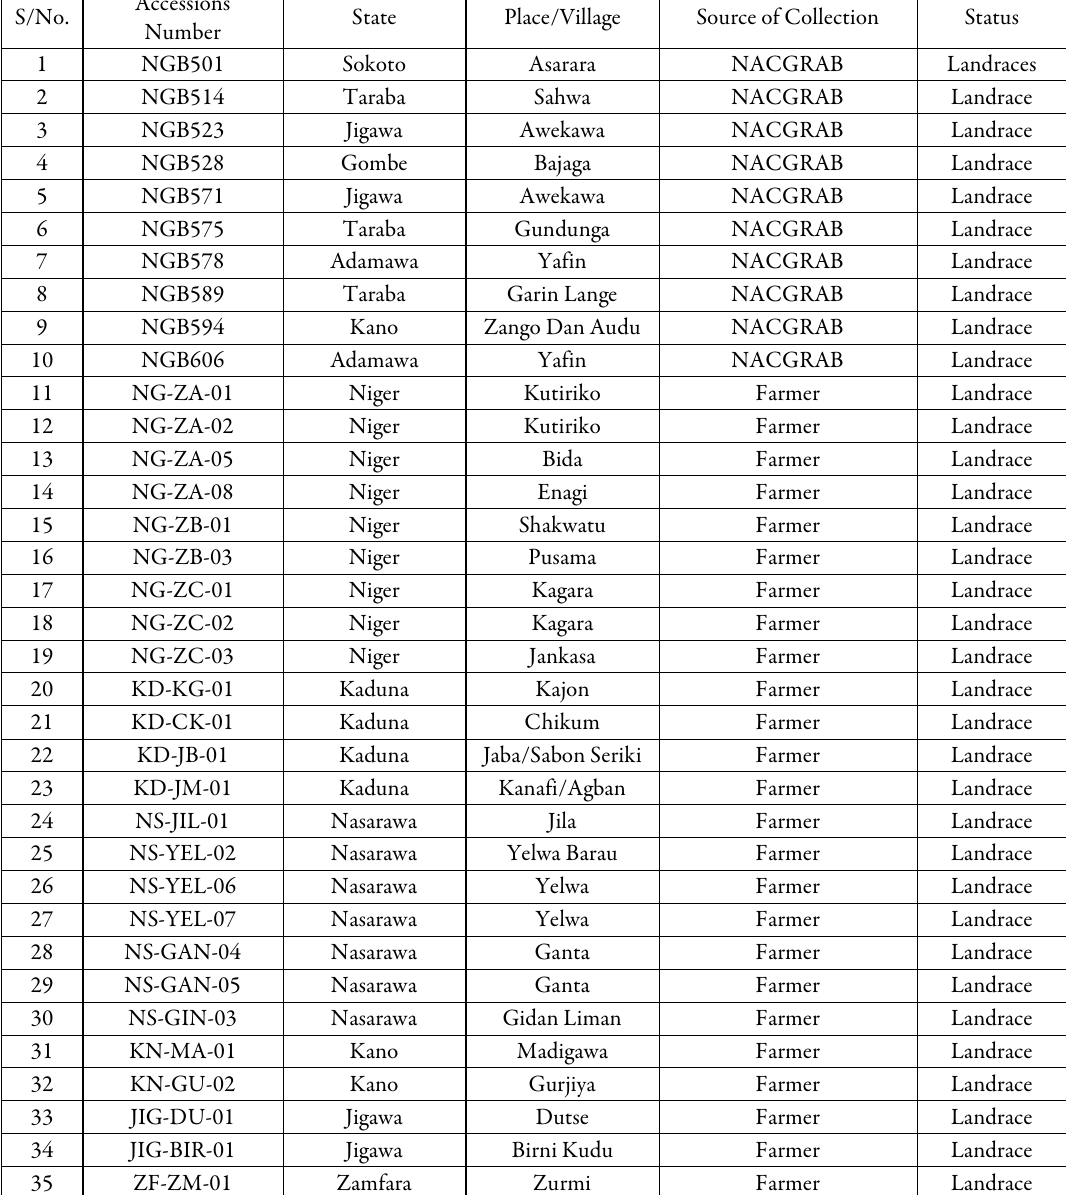
Table 1. Germplasm information on collected 35 pearl millet landraces